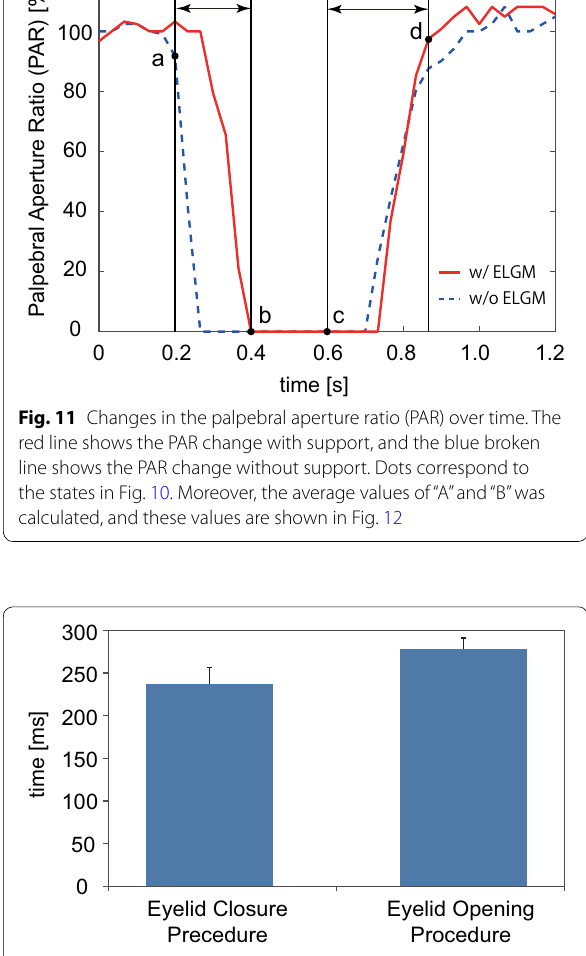
Fig. 12 Obtained experimental values. “Eyelid closure procedure” is the time from eyelid closure detection to completion of eyelid closure, which is shown as the average value of “A” in Fig. 11. “Eyelid Opening Procedure” is the time from eye opening detection to completion of eyelid opening, which is shown as the average value of “B” in Fig.